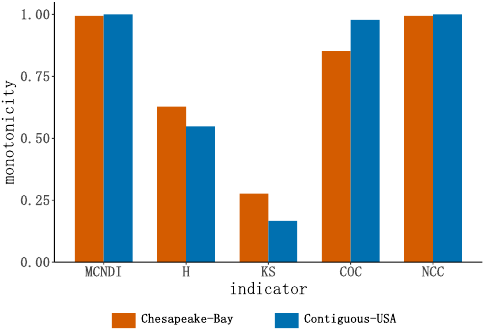
Figure 5. Monotonicity performance of different metrics on simulated